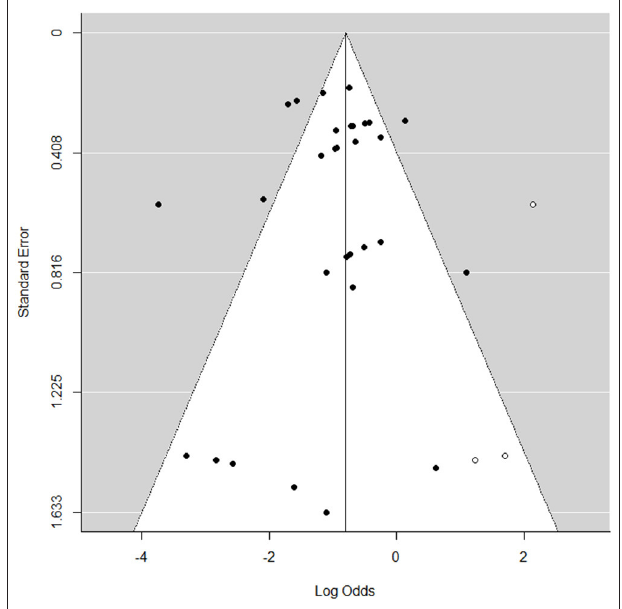
FIGURE 8 | Funnel plot publication bias of antimicrobial resistance rate of Klebsiella spp.